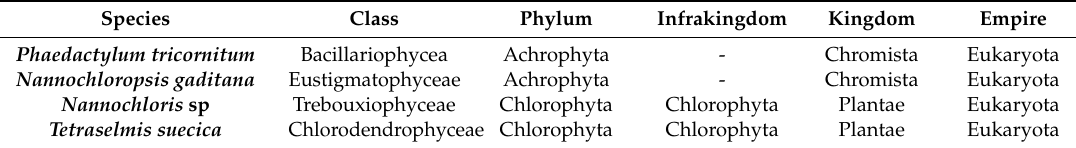
Table 6. Main taxonomic classification of the marine microalgae under study.